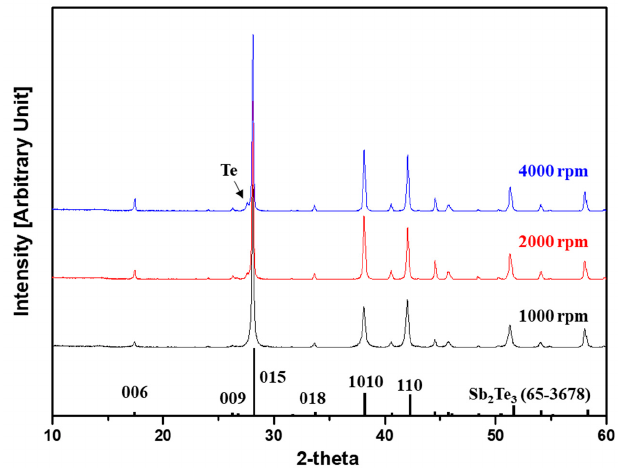
Figure 3. The XRD patterns of polycrystalline bulks of Bi 0.36 Sb 1.64 Te 3 fabricated from melt-spun ribbons at 1000, 2000, and 4000 rpm wheel rotation speed during the MS process. The bottom is the typical peak of Sb 2 Te 3 (JCPDS # 65-3678).